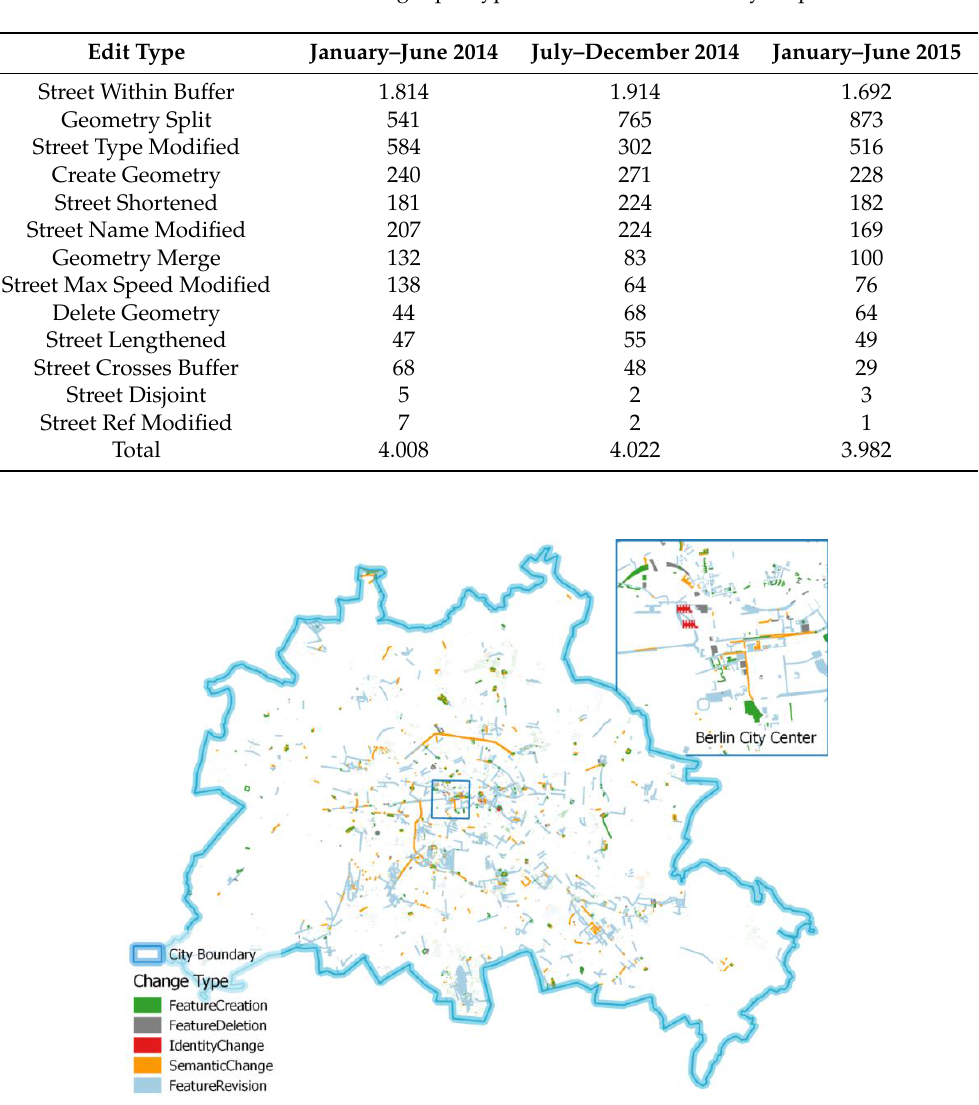
Figure 10. Change map of Berlin showing classified changes between January and June 2015.